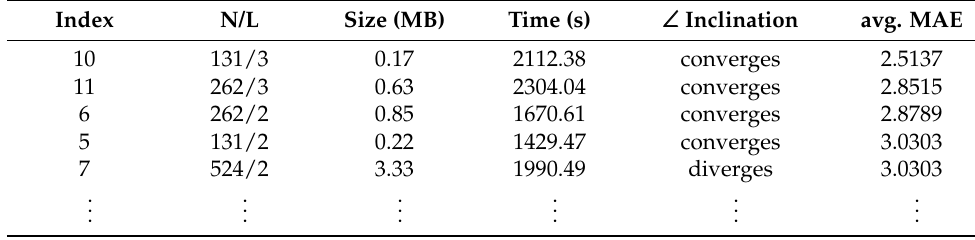
Table 6. Hyperparameters’ selection, sorted by average